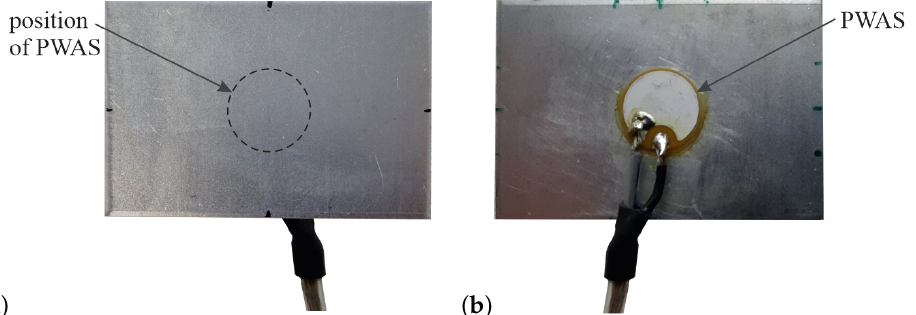
Figure 2. Aluminum specimen with applied and contacted PWAS: ( a ) top side and ( b ) bottom side with applied and contacted PWAS.